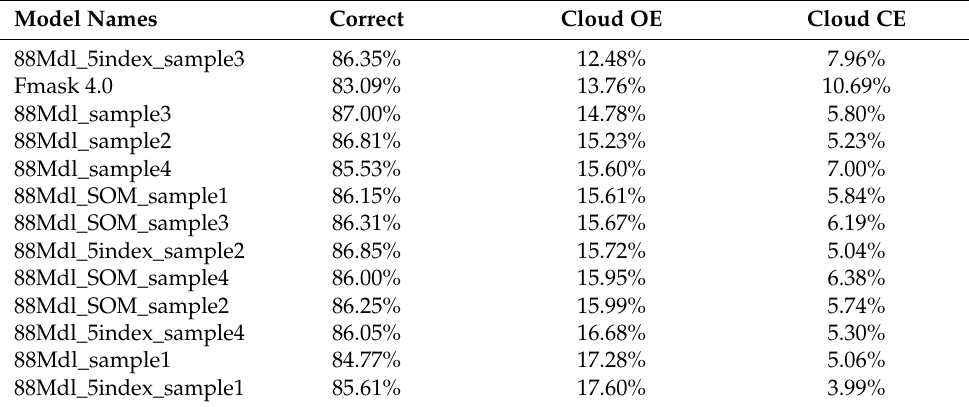
Table 6. Ultra-group accuracy assessment for machine learning models and the